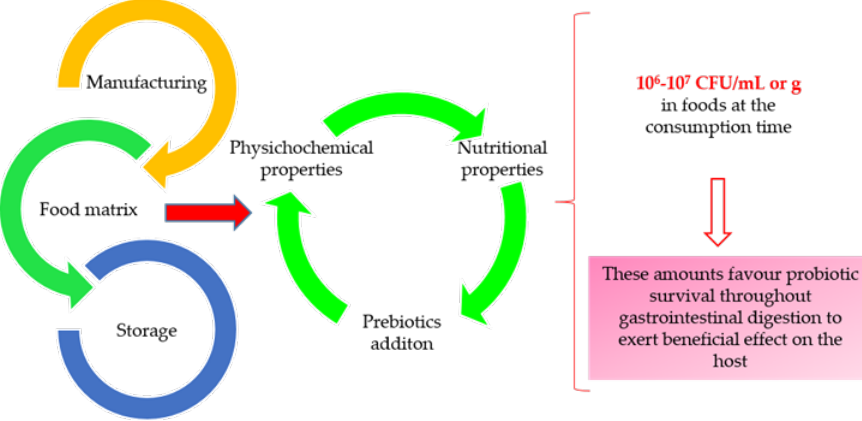
Figure 2. Important factors to be considered when assessing afermented non-dairy beverage matrices as potential carriers for the viability of probiotic